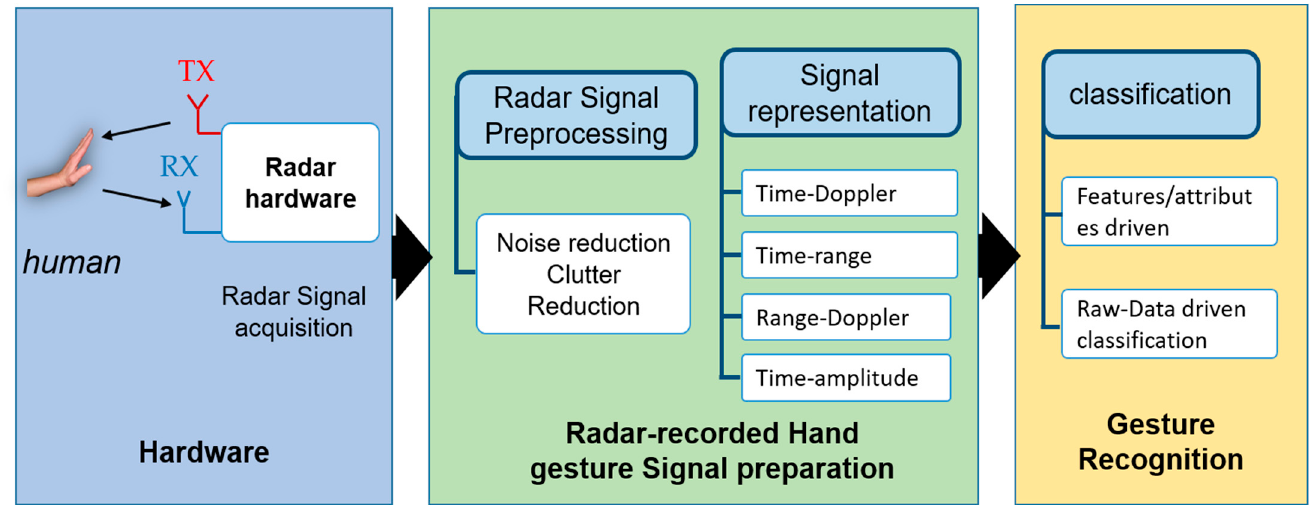
Figure 3. HCI with radar-recorded hand-gestures as an input: Predefined hand gesture is performed by users in radar cross-sectional area. This signal is passed through a clutter reduction filter and the signal is represented in any of the mentioned signal representation schema. Finally, recognition is performed.